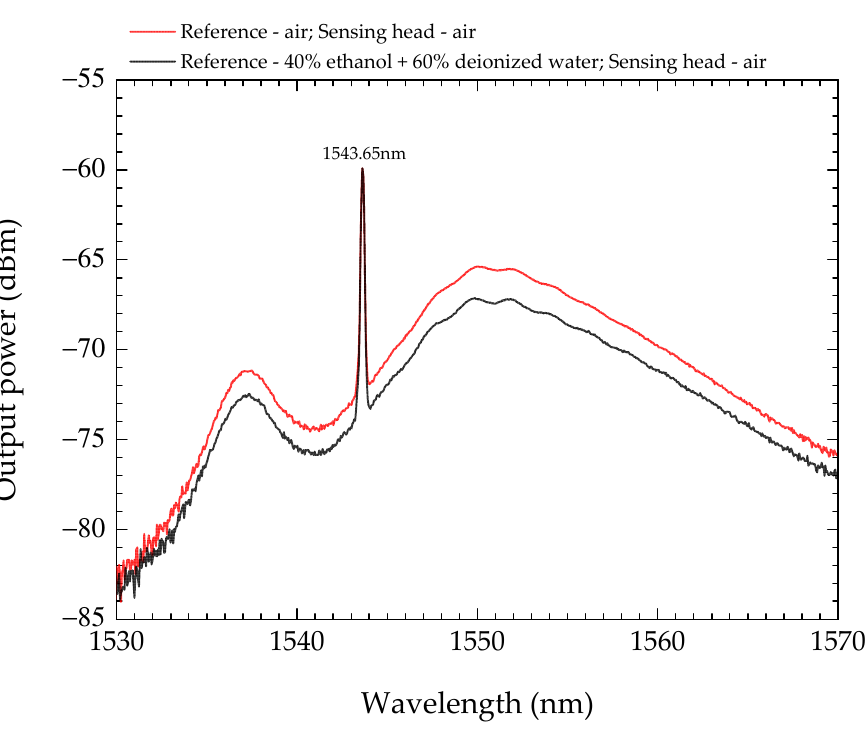
Figure 5. EDFRC output spectra pumped by a 976 nm laser at 20 mW when both reference port and sensing head were in air (red line) and reference port was in the reference solution and sensing head was in air (black line).